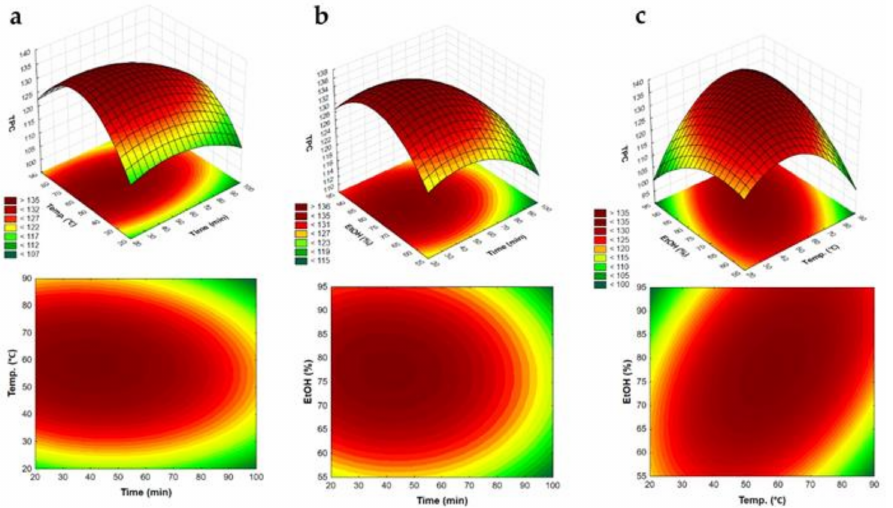
Figure 2. Response surface plot showing the combined effect of temperature ( ◦ C) ( a ), time (min) ( b ), and EtOH (%) ( c ) on the TPC of Brazilian red propolis